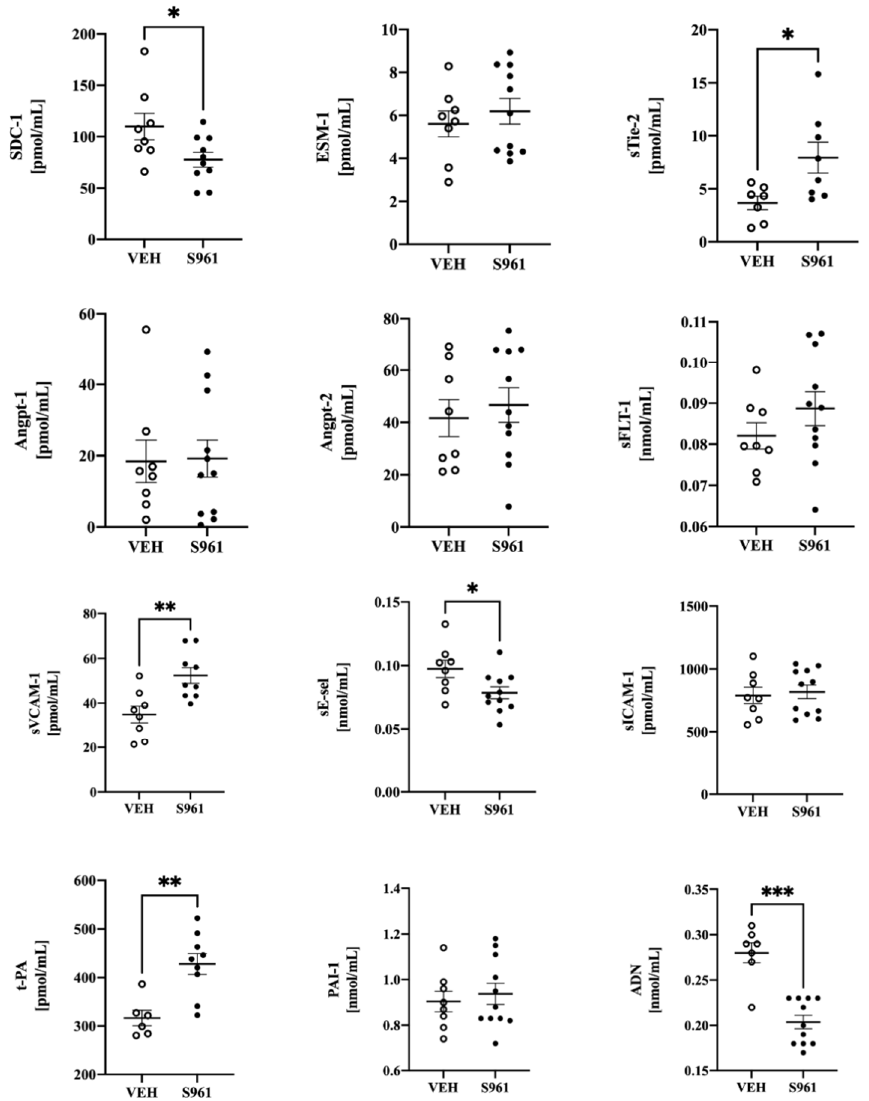
Figure 3. Effects of S961 treatment on selected plasma biomarkers of endothelial dysfunction. Biomarkers of glycocalyx disruption: syndecan-1 (SDC-1), endocan (ESM-1); endothelial permeability: soluble Tie-2 (sTie-2), angiopoietin 1 and 2 (Angpt-1/2), soluble fms-like tyrosine kinase (sFLT-1); endothelial inflammation: soluble form of E-selectin (sE-sel), soluble intercellular adhesion molecule 1 (sICAM-1), soluble vascular cell adhesion molecule 1 (sVCAM-1); hemostasis and others: tissue plasminogen activator (t-PA), plasminogen activator inhibitor 1 (PAI-1) and adiponectin (ADN). VEH n = 6–8, S961 n = 8–11. Statistical significance tested using two-sided Student’s t -test with Welch’s correction, normality confirmed by Shapiro–Wilk test, variance by F-test. Results shown as mean +/ − SE. * p < 0.05, ** p < 0.01, *** p < 0.005.